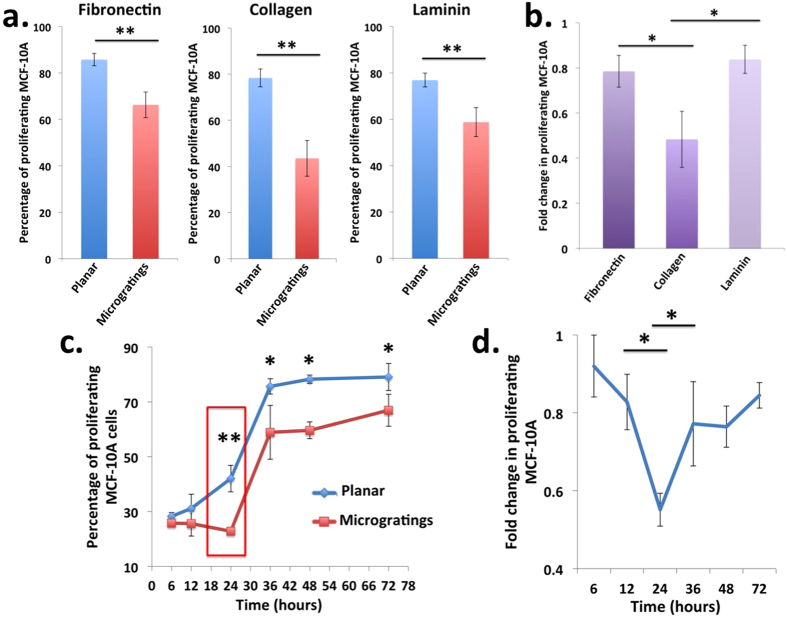
Microgratings induces greatest reduction in proliferation of MCF-10A cells for collagen coating after 24 hours of cell seeding.(a) MCF-10A proliferation was reduced by 2 μm microgratings across all the extracellular matrix (ECM) proteins, namely, fibronectin, collagen, laminin after 24 hours of cell seeding. Microgratings was coated with ECM proteins to facilitate cell adhesion, spreading and proliferation. (b) Greatest reduction in proliferation was observed for collagen coating. (c) Maximum reduction in proliferation occurred for collagen coating after 24 hours of cell seeding (indicated by red box). Blue and red colored line indicates the growth curve of cells seeded on planar and 2 μm microgratings respectively. Data are means ± s.e.m. (n = 3). For each experiment, 300 cells were considered on an average. P values were obtained using Student’s unpaired t-test. **p < 0.01 and *p < 0.05 with respect to planar. (d) Fold change calculation in proliferating cells as a function of time. *p < 0.05